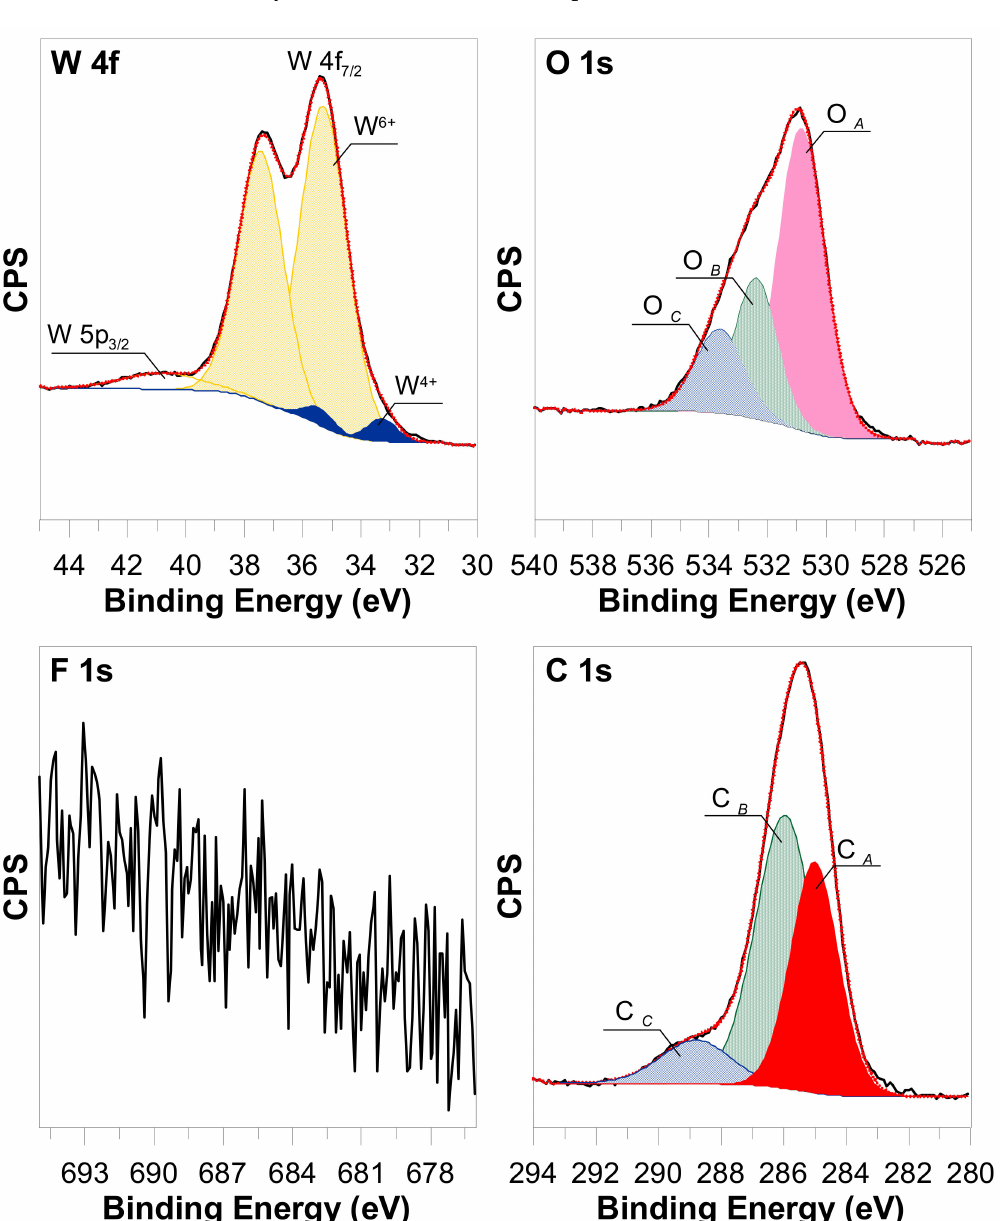
Figure 5. High resolution XPS spectra of WO 3 nanopores array formed by an optimized anodiza- tion